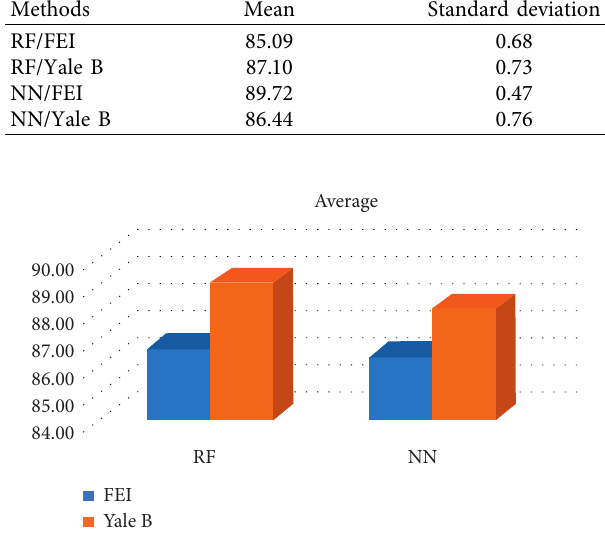
Figure 13: The average accuracy rate series of experiments on FLBP using the FEI and Yale B datasets.